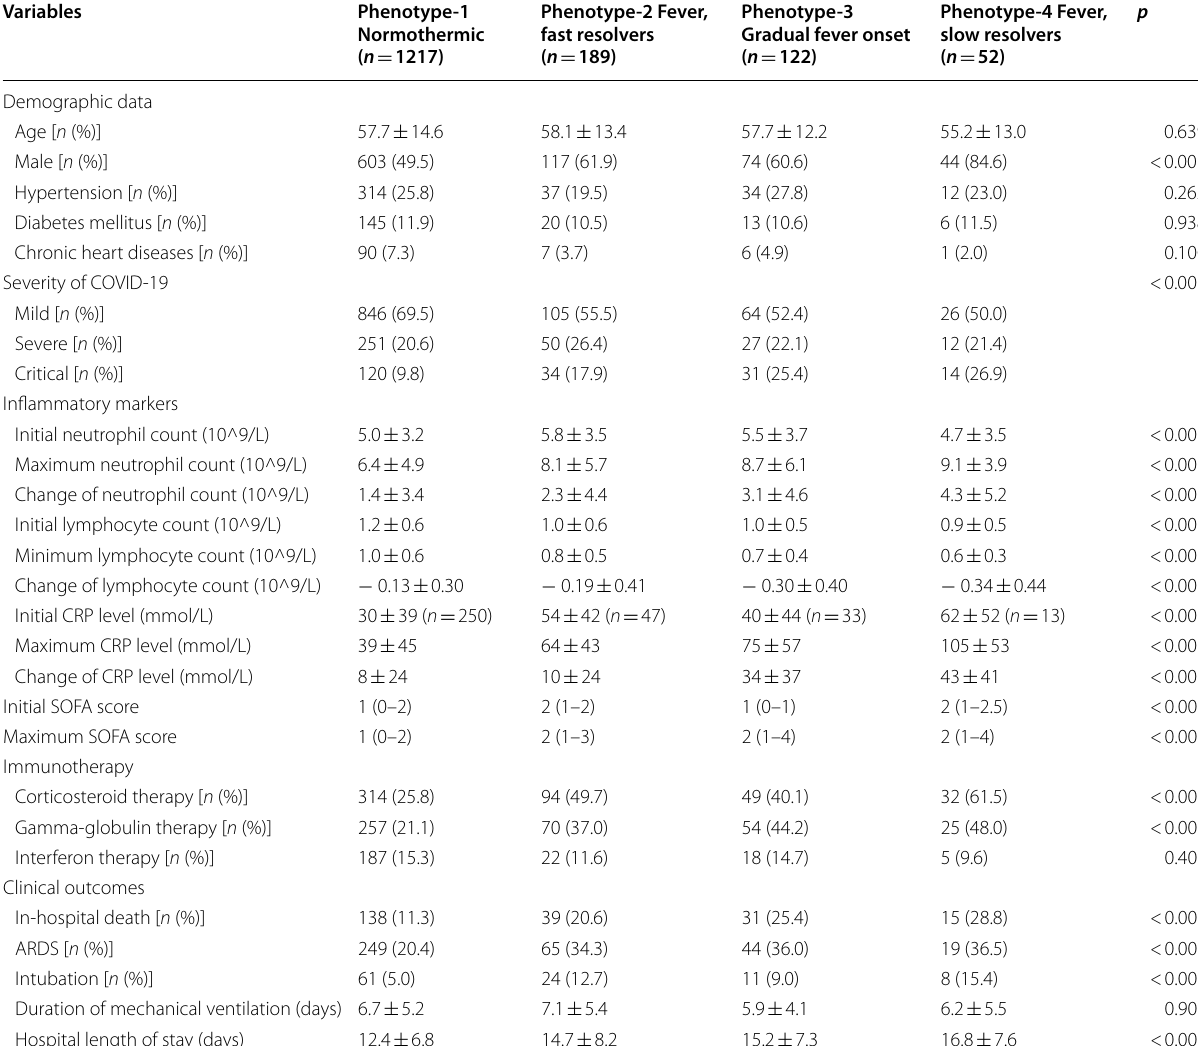
Table 3 Comparison of patient characteristics, therapy, and outcome within the four temperature-trajectory phenotypes